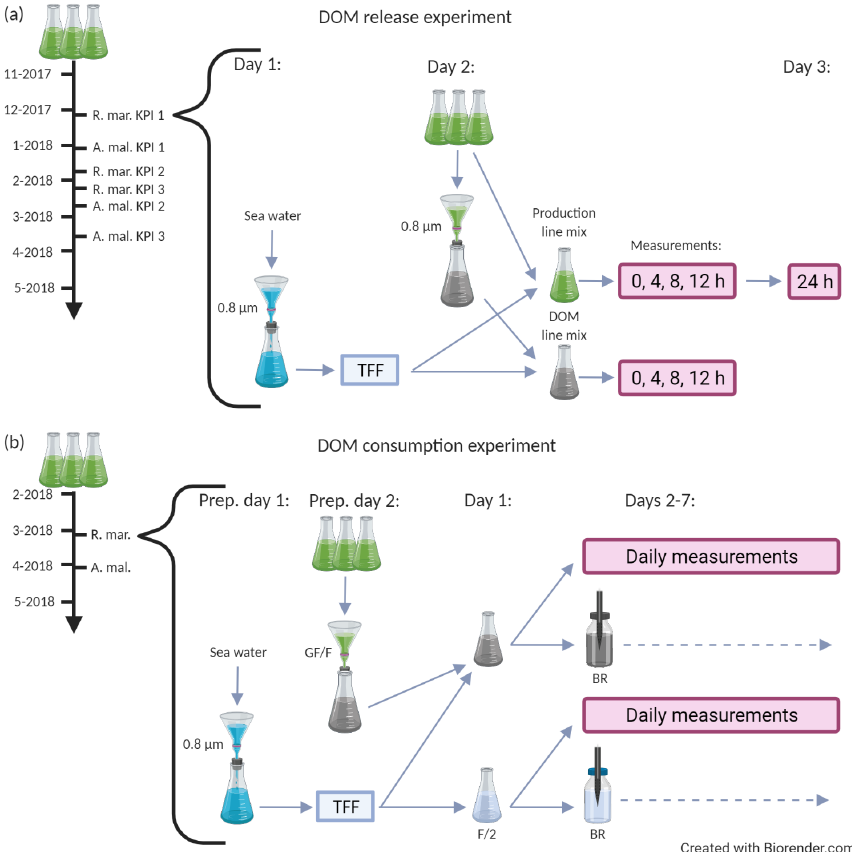
Figure 1. A schematic description of the DOM release experiment (a) and the DOM consumption experiment (b) . Both experiments were conducted separately for A. malmogiense and R. marina . The black timeline arrow at the far left starts from the inoculation of phytoplankton into 5L growth vials. During the timeline phytoplankton abundance and optical properties of DOM were measured one to three times a week. Grey arrows depict the flow of water through different filtration, mixing, and measurement steps. ( a , bracketed area) Procedure for an individual key point incubation, which were conducted thrice for each species. On day 1 the bacterial inoculum was prepared, on day 2 the incubation was initiated (i.e., phytoplankton treatments were established) and measurements (production line: primary production, bacterial production, 14 C flow; DOM line: DOC, CDOM, bacterial abundance) were taken at 4h intervals, and on day 3 the final primary production measurement was taken (for net primary production). ( b , bracketed area) Incubation of the DOM consumption experiment, which was conducted once for each species. On preparation day 1 bacterial inoculum was prepared, on preparation day 2 the cultures were filtered, on day 1 the incubation was initiated (i.e., phytoplankton treatments were established), and measurements (DOC, CDOM, bacterial abundance, production, respiration, community composition, and growth efficiency) were taken daily until day 7. The variables measured at each phase of the two experiments are listed in Table 1. KPI: key point incubation (see text); BR: optical O 2 consumption (bacterial respiration) measurement; F/2: F/2 growth medium (control); TFF: concentration of bacteria by tangential flow